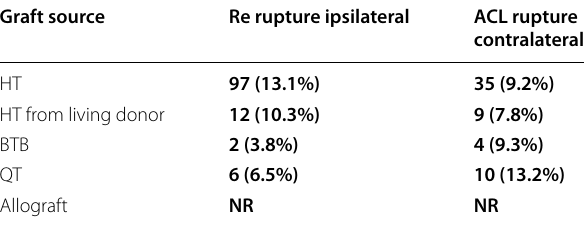
Table 3 Comparison of re-rupture rates of different grafts used in the included studies